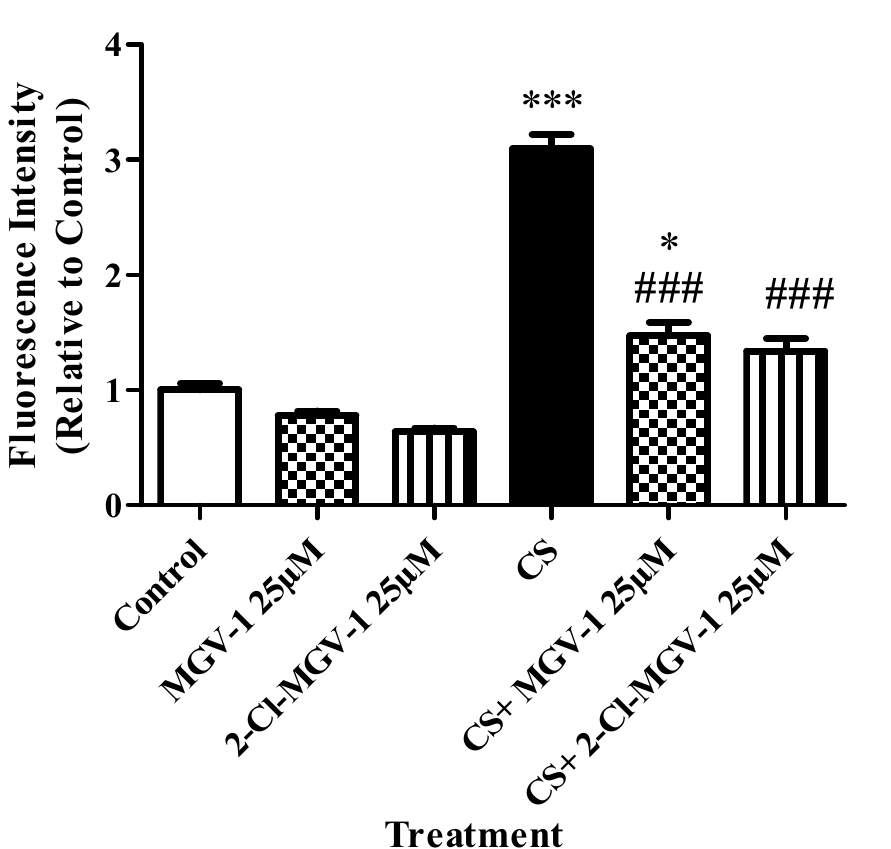
Figure 7. The protective capacity of TSPO ligands against CS-induced ROS production in H1299 lung cancer cells. ROS levels were measured by ELISA. CS significantly elevated oxidative stress levels, while TSPO ligands differentially prevented the CS-induced damage. The control, MGV-1 and 2-Cl-MGV-1 groups were exposed to fresh air only without exposure to CS. Results are represented as mean ± SEM ( n = 5 in each group). * p < 0.05 and *** p < 0.001 vs. control, ### p < 0.001 vs. CS. CS = cigarette smoke.